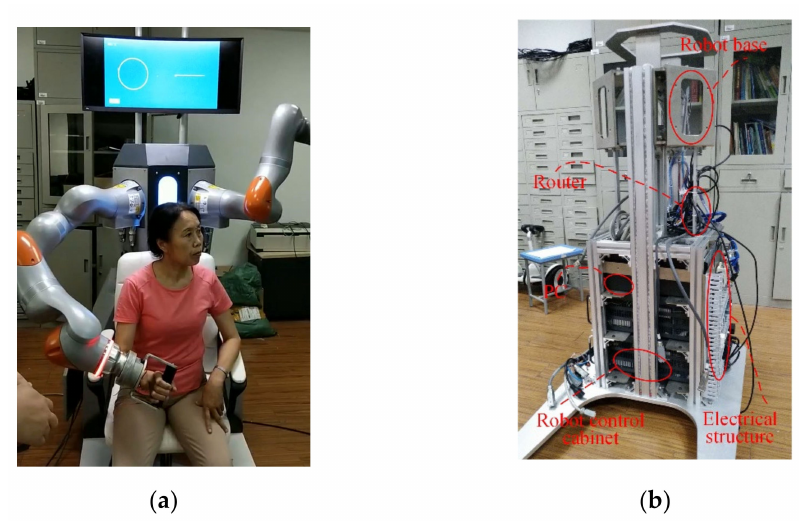
Figure 10. The subject testing and the detail structure of the rehabilitation robot. ( a ) The experimental testing with the subject and ( b ) the internal structure of the rehabilitation robot